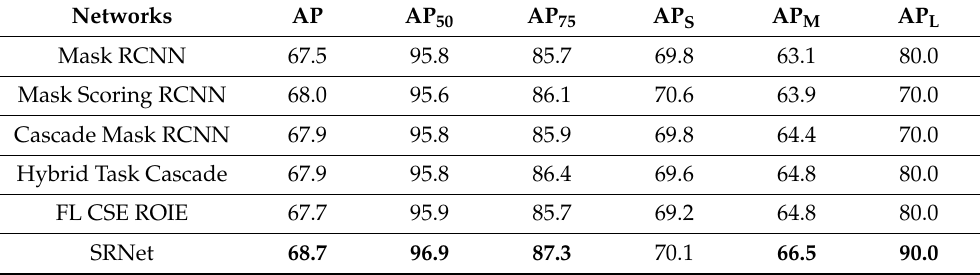
Table 4. Instance-segmentation performance of different networks on the Instance-RSDD